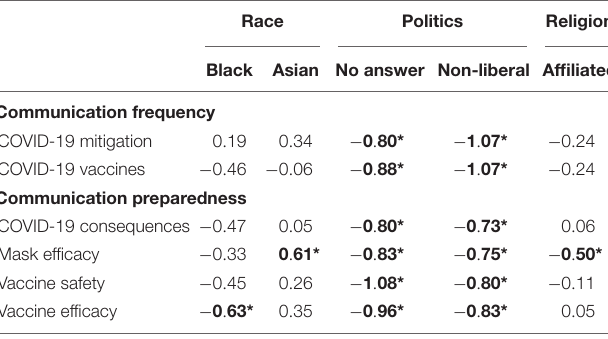
TABLE 4 | Coefficients from models predicting students’ COVID-19 communication frequency and their felt preparedness to communicate accurate